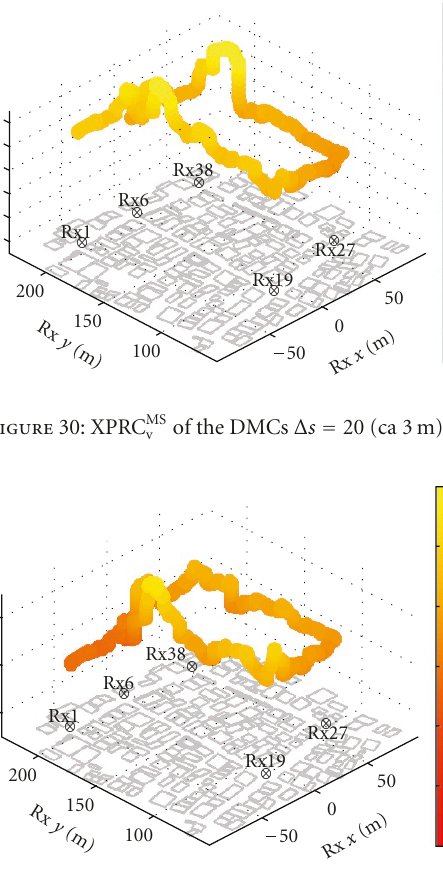
of the DMCs Δ s = 20 (ca 3m). h